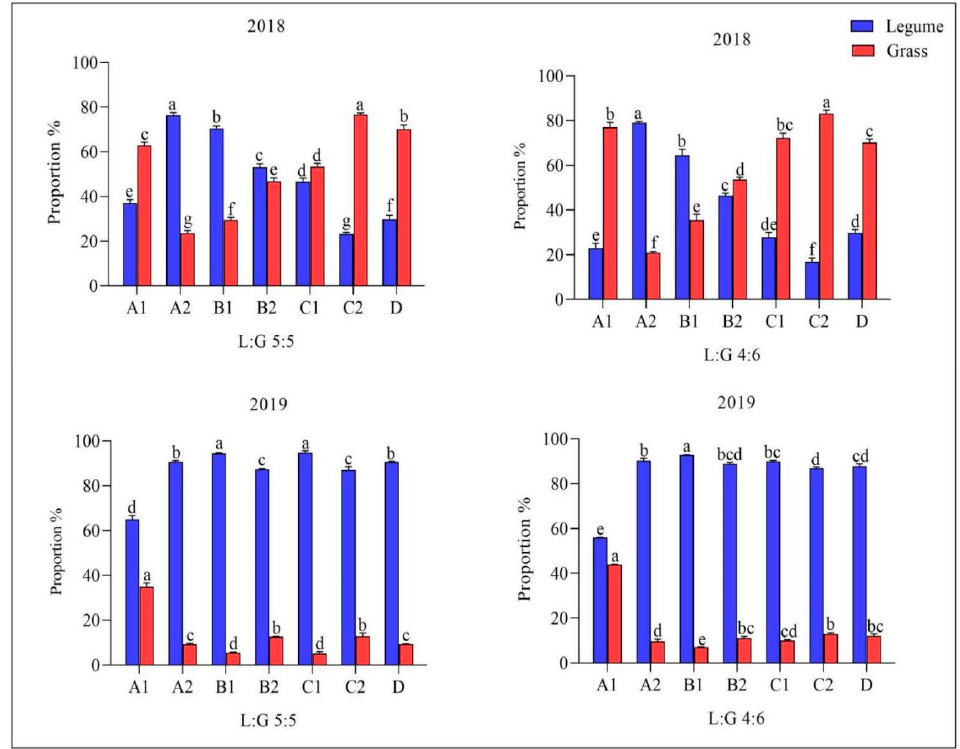
Figure 1. Legume/grass biomass yield proportions of legume–grass mixtures under two different legume-grass seeding ratios for consecutive two years. A1: white clover, orchardgrass, and tall fescue; A2: alfalfa, orchardgrass, and tall fescue; B1: alfalfa, white clover, orchardgrass, and tall fescue; B2: red clover, white clover, orchardgrass, and tall fescue; C1: alfalfa, white clover, orchardgrass, tall fescue, and perennial ryegrass; C2: red clover, white clover, orchardgrass, tall fescue, and perennial ryegrass; and D: alfalfa, red clover, white clover, orchardgrass, tall fescue, and perennial ryegrass. The small letters indicate the significant difference between legume or grass proportions between legume–grass mixtures. Significant difference test was performed at probability level of